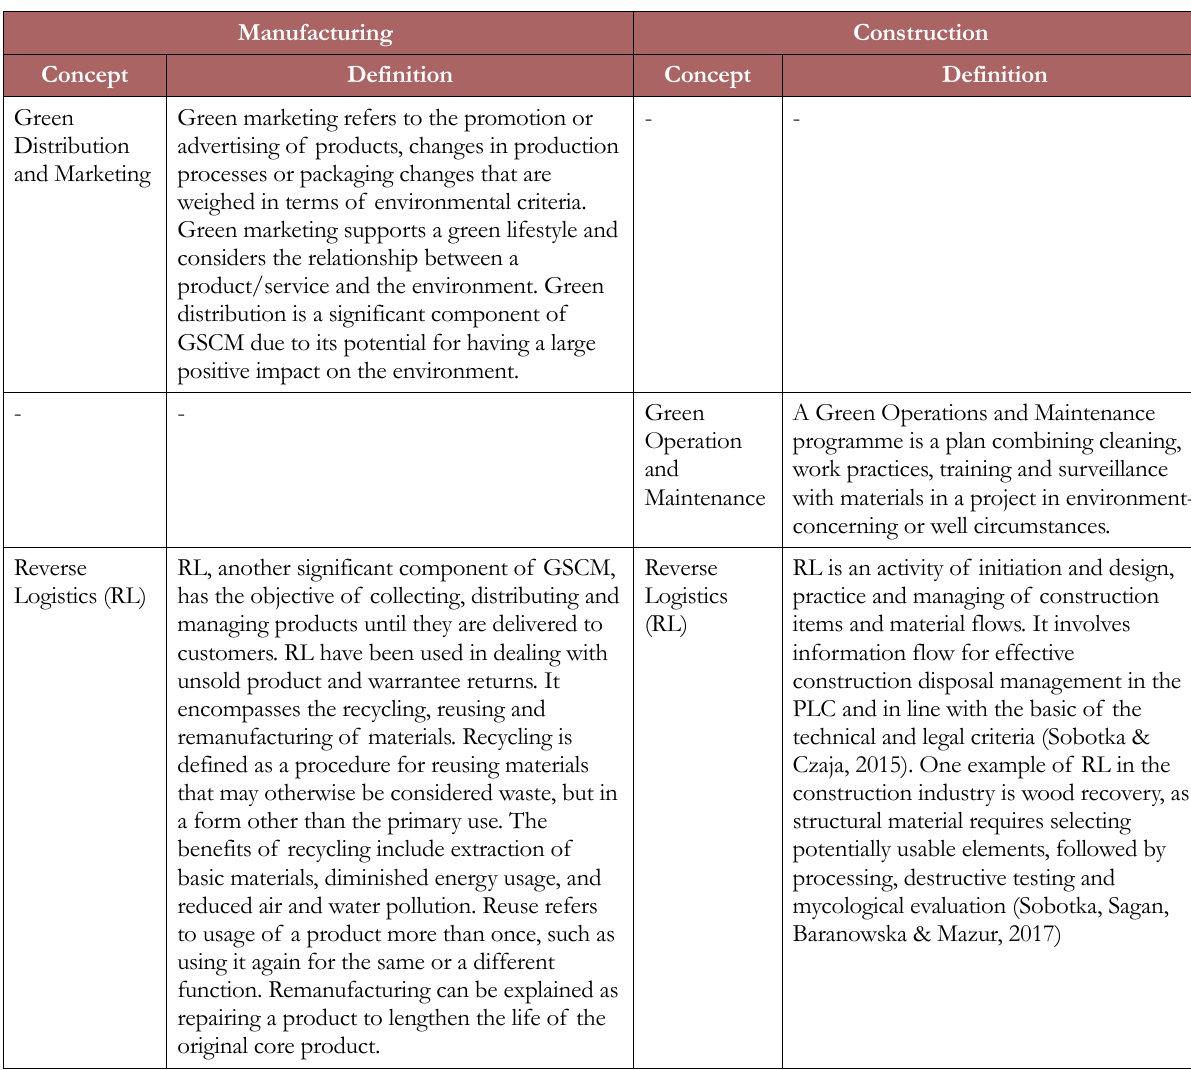
Table 2. Operational Definition of